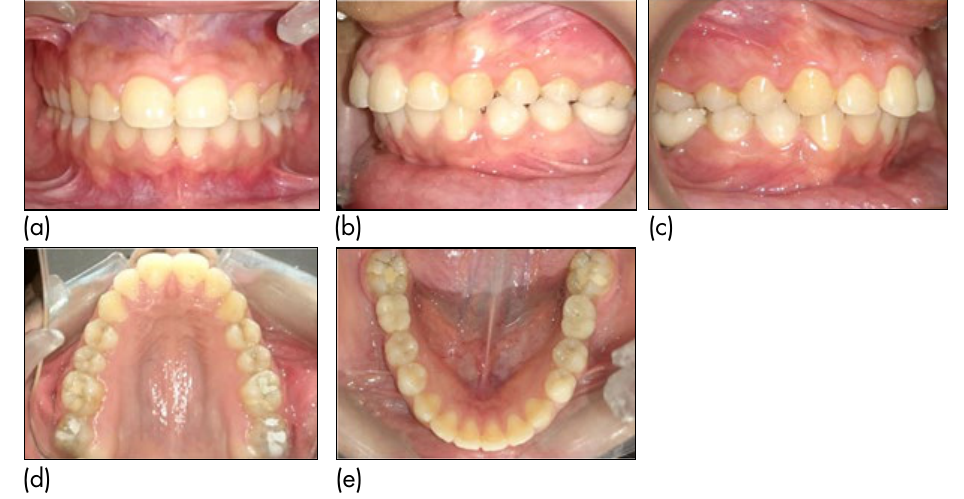
Figure 9 (a, b, c, d, e). Post-retention intra-oral photographs.